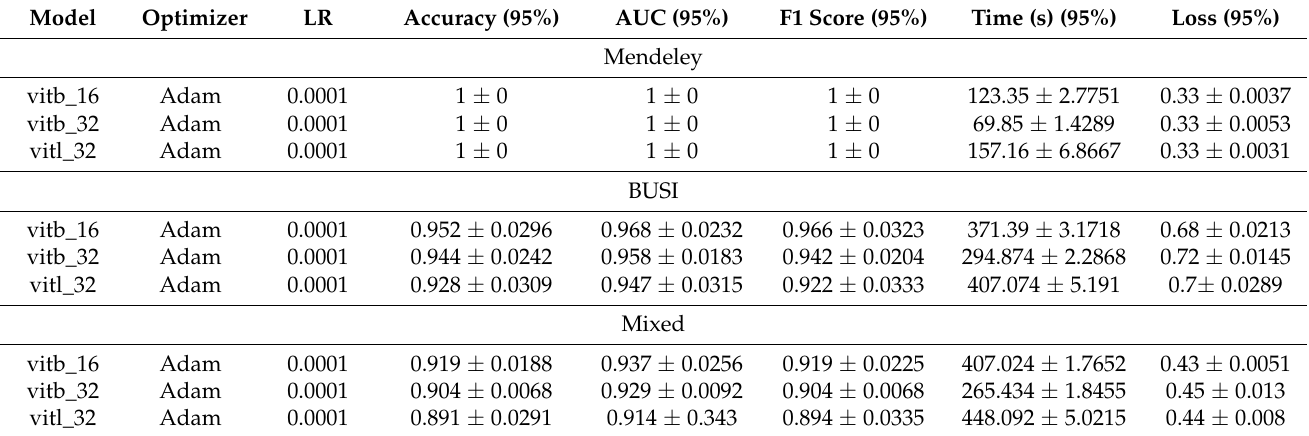
Table 3. The performance of the proposed method: BUSI, breast ultrasound image dataset; LR, learning rate; s, seconds; AUC, area under receiver operating curve.